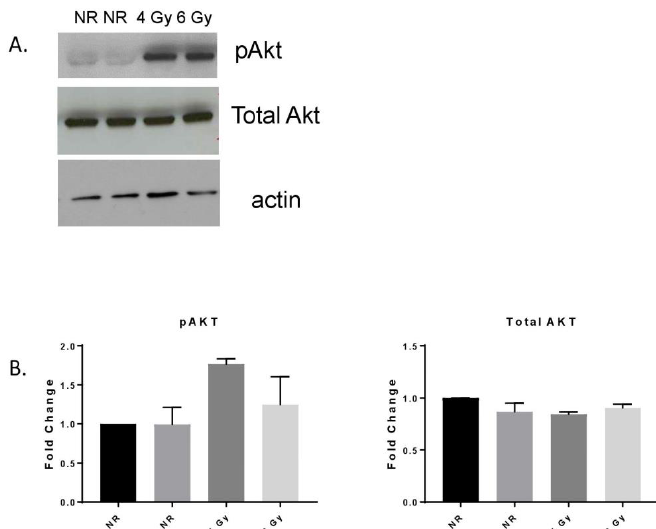
Figure 1. MF-radiation exposure activated Akt signaling in hBMEC. Cells were nonirradiated (NR) (2 samples) or irradiated (R) with 4 or 6 Gy. Cells were lysed 4 h after exposure and Akt phosphorylation was detected by Western blot ( A ). Densitometry was performed on three independent experiments, normalized to actin ( B ). Error bars represent standard deviation. The pAKT level in the 4 Gy sample was near significance ( p = 0.0501) compared to NR.